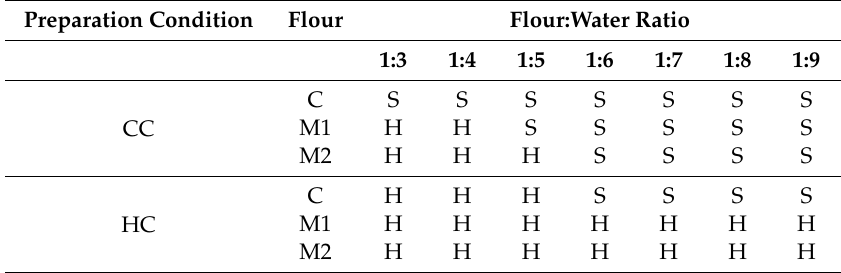
Table 2. Physical appearance of corn flour:water systems subjected to mixing for 2 min at 135 rpm under the cold condition (CC) or hot condition (HC). H means that flour:water systems obtained were homogeneous while S means that flour:water systems showed water